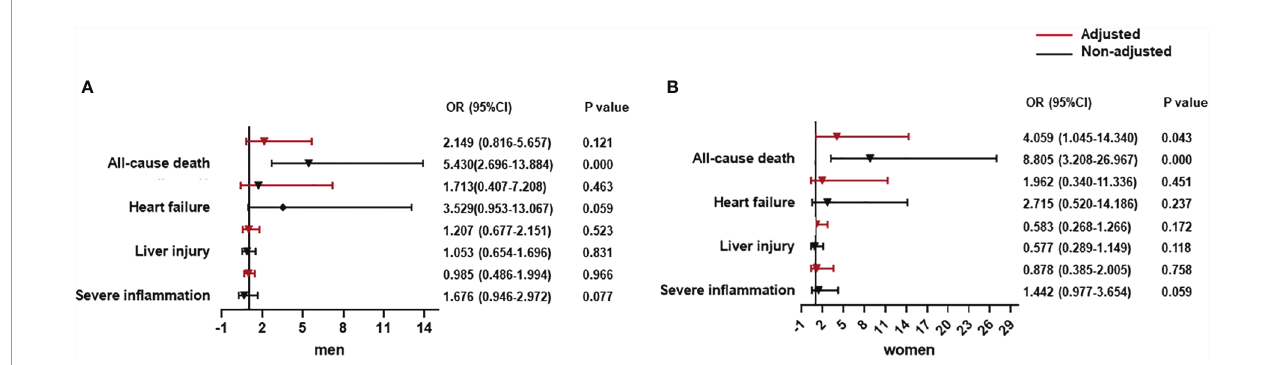
FIGURE 2 | The association between CysC and organ dysfunction and all-cause death in diabetes population classi fi ed by sex. (A) The association between CysC and organ dysfunction and all-cause death in the male diabetes population. (B) The association between CysC and in the female diabetes population. Severe in fl ammation was de fi ned as the highest NLR >6.11 during hospitalization; liver injury was de fi ned as a level of ALT >40 U/L at any time during hospitalization; and heart failure was de fi ned as the highest level of NT-proBNP>300 pg/mL during hospitalization. Adjusted by age, severe pneumonia, serum albumin, blood glucose,